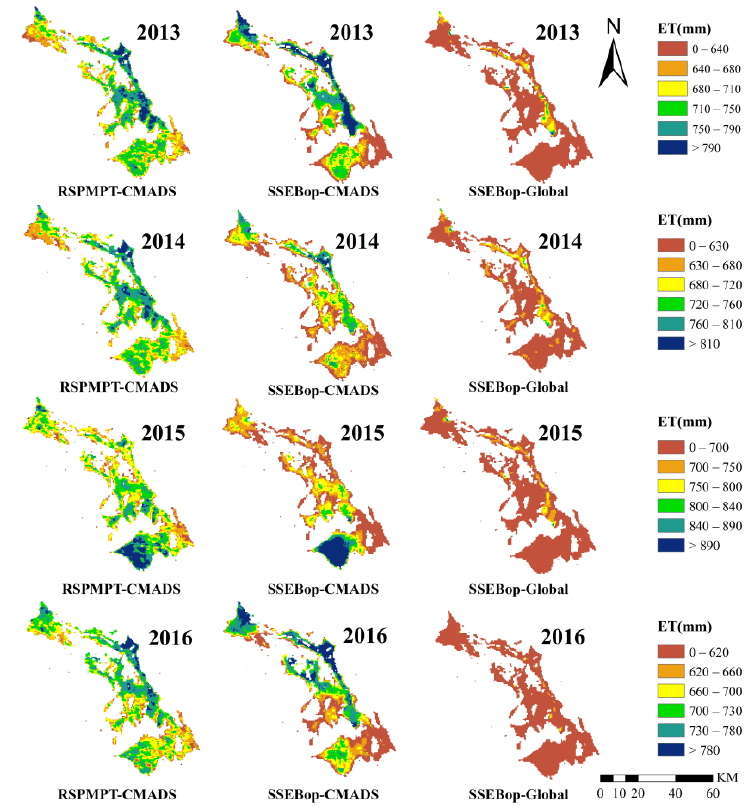
Figure 4. Annual accumulated evapotranspiration of the study area derived from the three ap- proaches (RSPMPT-CMADS, SSEBop-CMADS, SSEBop-Global) from 2013 to 2016.